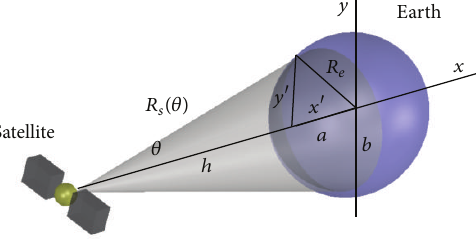
Figure 2: Electromagnetic illumination in the equatorial pole of the